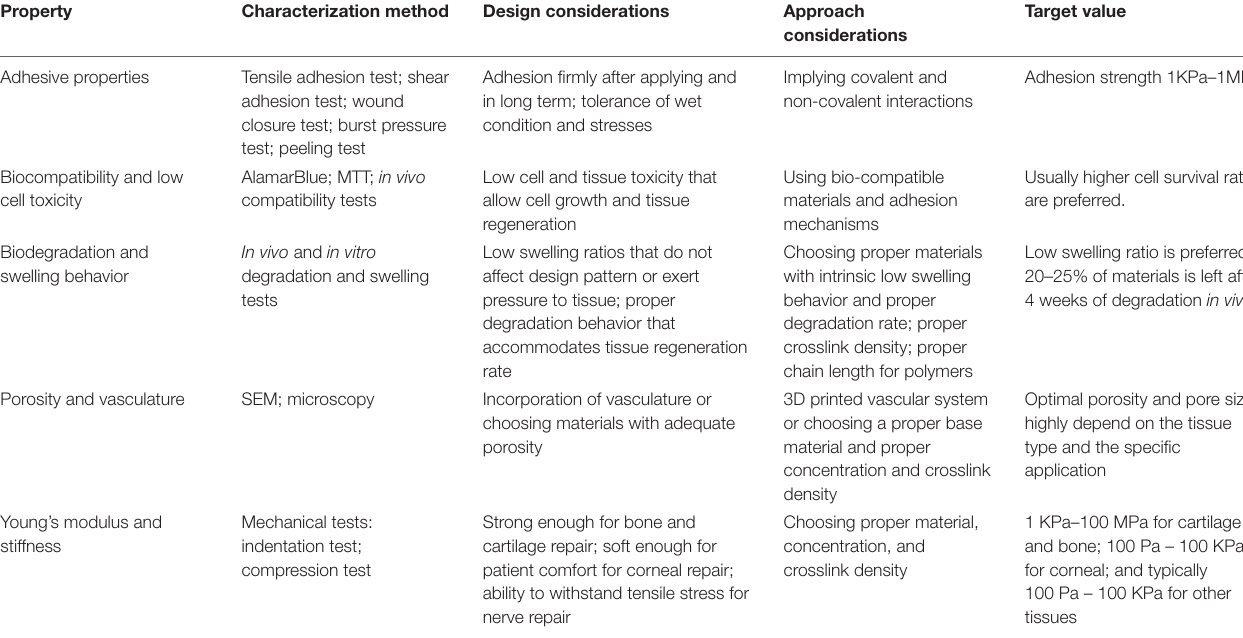
TABLE 1 | Main required properties for adhesive tissue engineering scaffolds